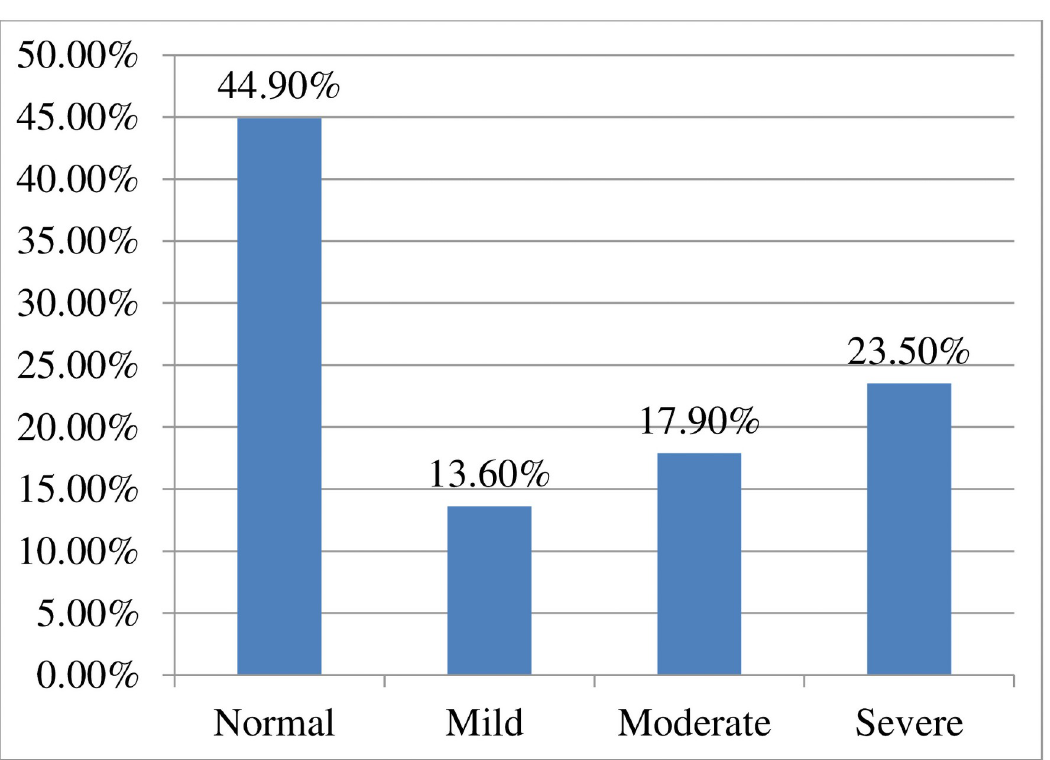
Fig 1. Severity of post-traumatic stress disorder on health care providers in South Gondar zone hospitals, Amhara, Ethiopia, 2020.